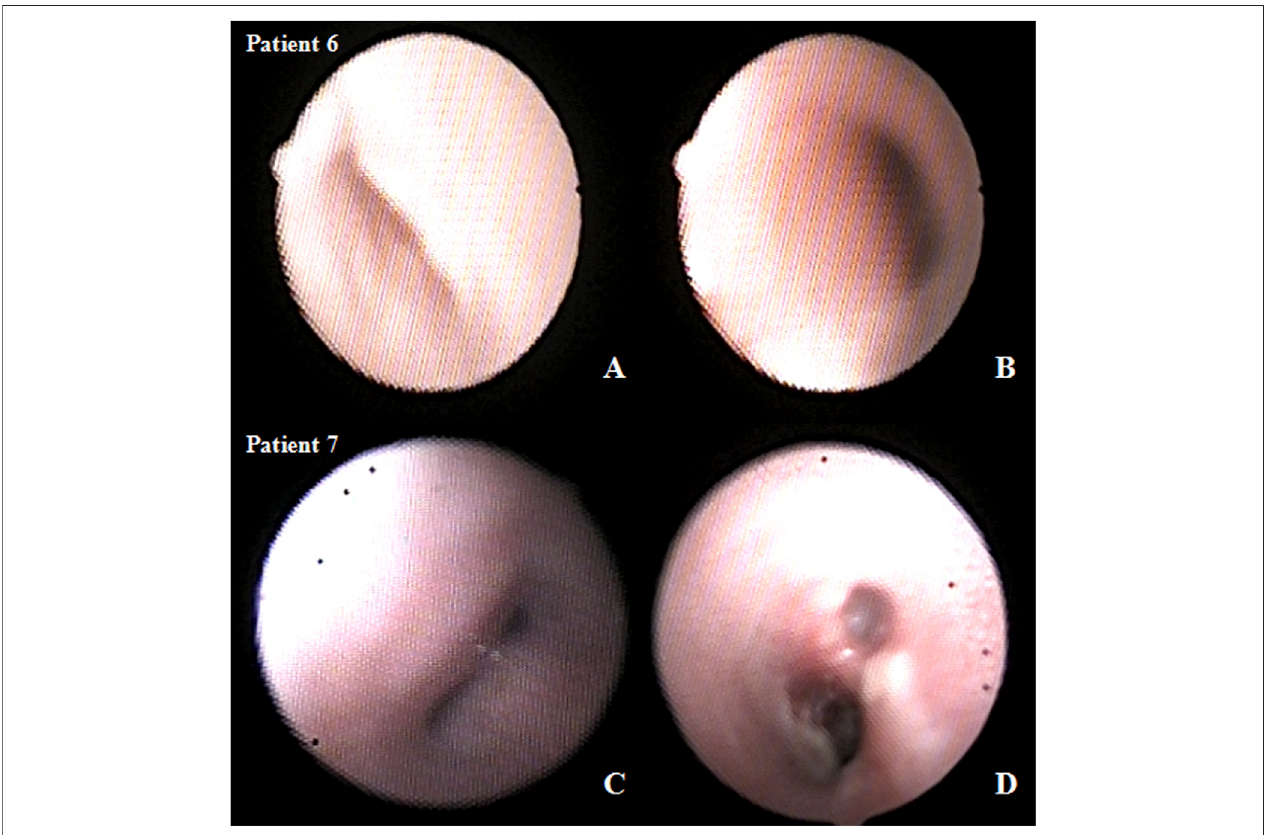
FIGURE 2 | Preoperative and postoperative three-dimensional computed tomography (3D-CT) images after airway external splint suspension. (A) preoperative and (B) 1-year after operation 3D-CT images in patient six and (C) preoperative and (D) 1-year after operation 3D-CT images in patient 7.